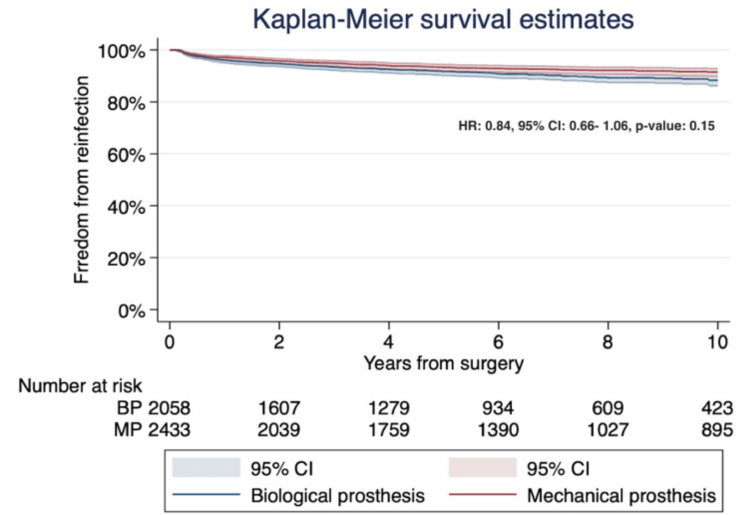
Figure 9. Kaplan–Meier curves detailing the freedom from prosthesis reinfection. No statistical differences were reported between mechanical and biological prostheses. Abbreviations: HR, hazard ratio; CI, confidence interval; MP, mechanical prosthesis; and BP, biological prosthesis.